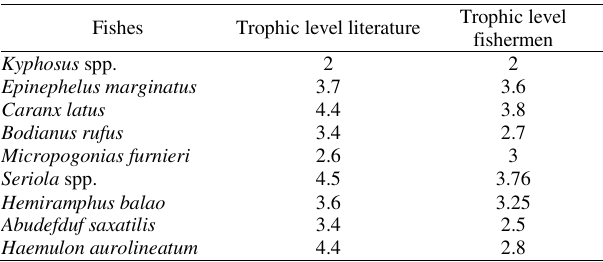
Table 3. Trophic levels for the nine studied fish species based on data gathered from the interviewed fishermen in Búzios Island and from the biological literature (Froese & Pauly, 2011).